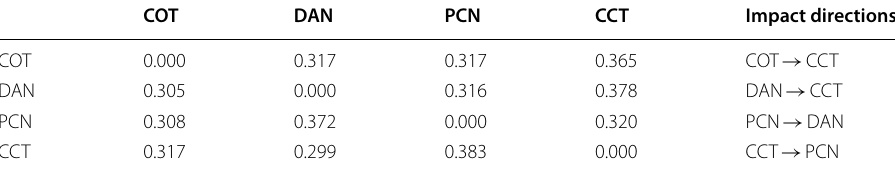
Table 7 Normalized relation matrix and the impact directions COT DAN PCN CCT Impact directions COT 0.000 0.317 0.317 DAN